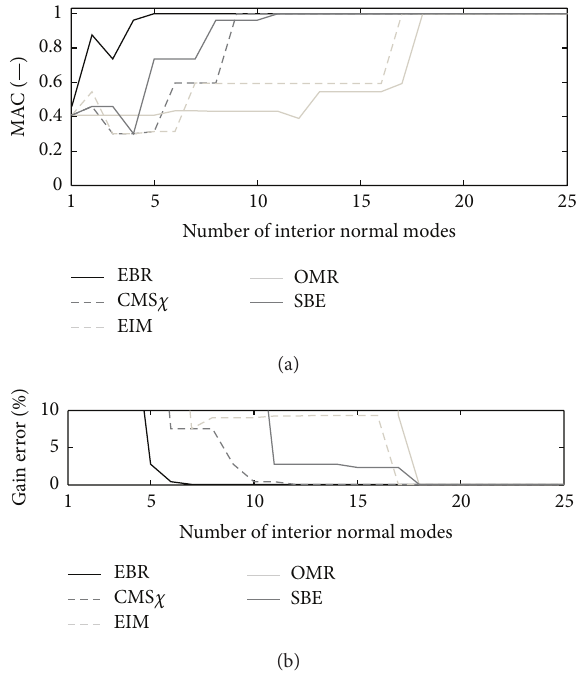
Figure 7: MAC (a) and 𝜀 𝑔 (b) versus number of interior